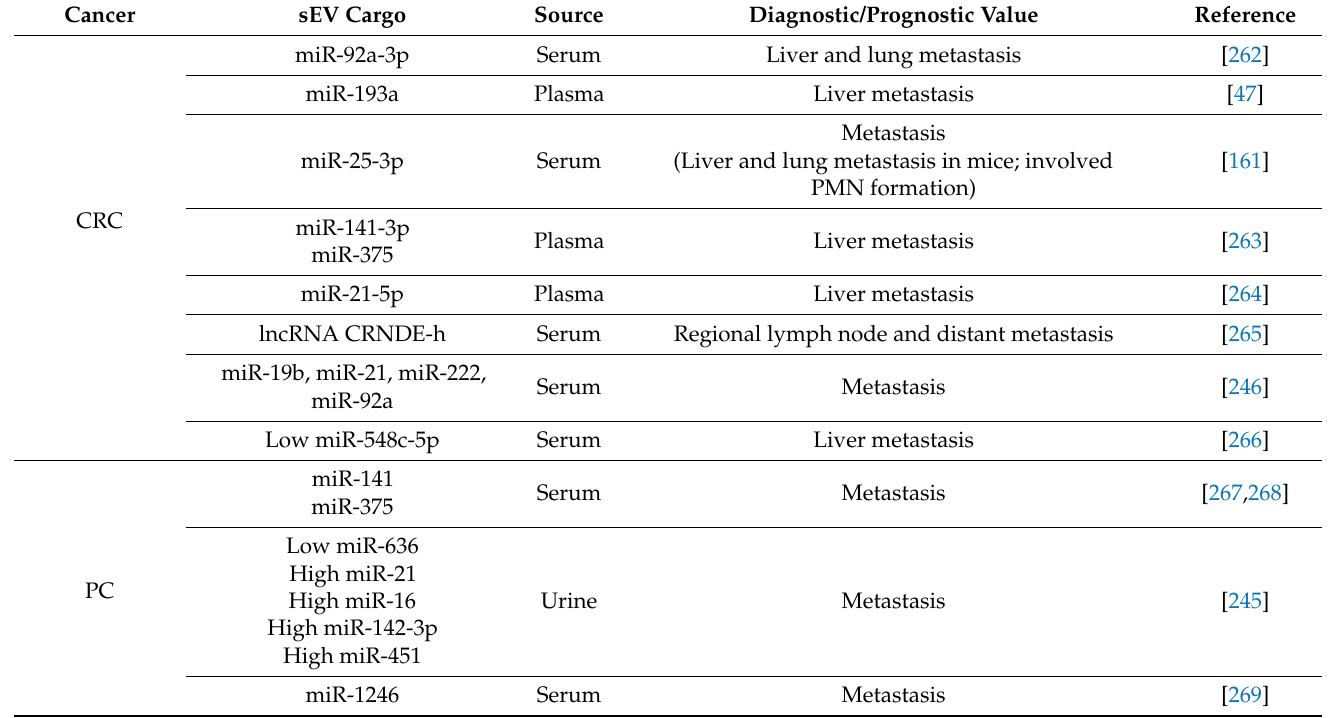
Table 2. sEV-ncRNA cargo used as diagnostic and prognostic biomarkers in